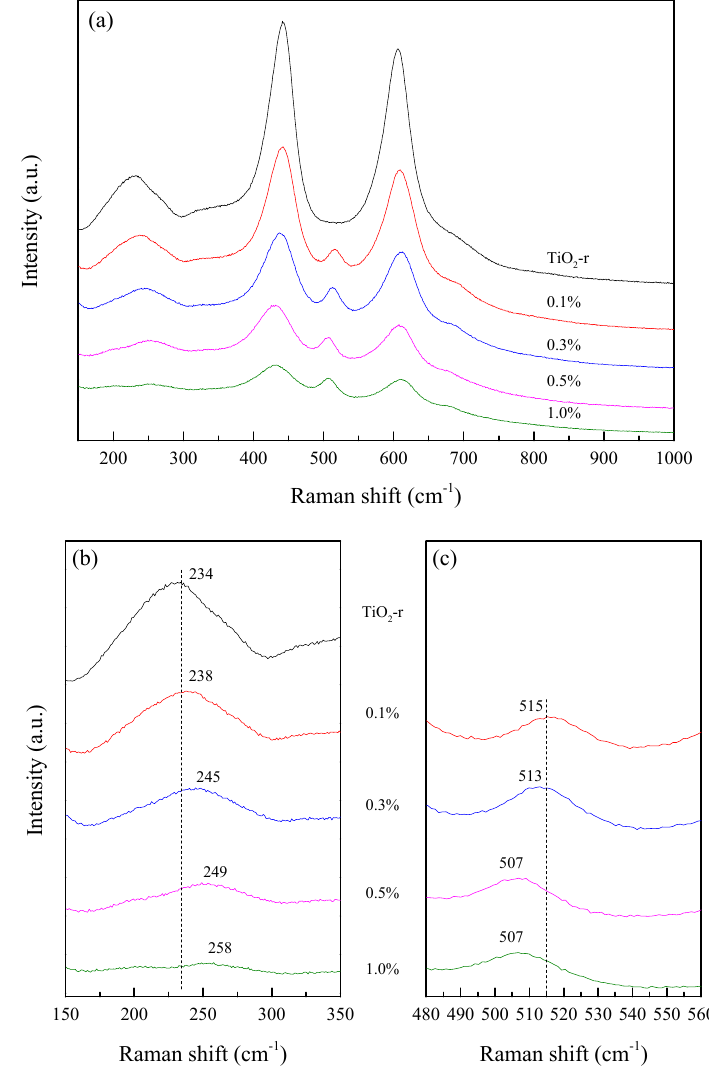
Figure 8. Raman spectra of TiO 2 -r and RuO 2 /TiO 2 -r with 0.1, 0.3, 0.5, and 1.0 wt% Ru loading ( a ) and partial enlarged views of TiO 2 -r ( b ) and RuO 2 ( c ).